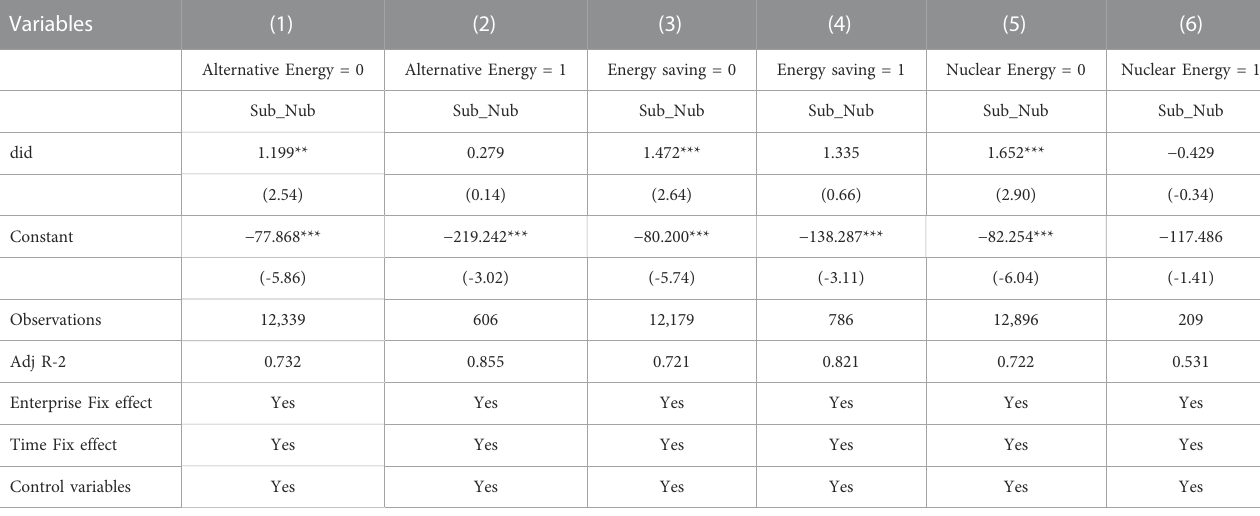
TABLE 6 Alternative energy response of enterprises to the